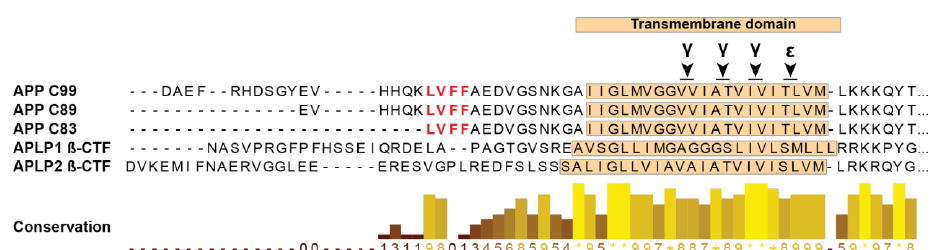
Figure 2. Processing of the APP protein family. ( A ). Illustration of APP processing. The sites of α , β , and β ’ cleavage are shown with amino acids corresponding to cleavage position. Upon cleavage by α - or β -secretase, fragments called s APP α , s APP β and s APP β ’ are released and secreted and C83, C89, or C99 remain embedded in the membrane, respectively. C99 contains the complete A β sequence, while C89 and C83 have truncated (11-X and 17-X, respectively) A β sequences. The A β 17-X is also called the P3 fragment. The first cleavage by γ -secretase occurs at the ε site to release AICD prior to intramembrane proteolytic cleavage of 3 or 4 amino acids to produce amyloid β (A β ) peptides from 36 to 43 amino acids. ( B ). Sequence alignment of APP C99, C89, C83 and APLP1 /2 β -CTF. The alignment illustrates sequence differences between the members of the APP family. The bottom panel highlights amino acids from most conserved (yellow) to less conserved (dark brown). The LVFF motif (red) is present only in APP while the C-terminal fragment is similar between APP and APLP2 . The cleavage sites of γ -secretase are mostly conserved between all members of the APP family. The bottom chart illustrates the conservation of amino acid per position based on their properties with values ranging from 0 (no conservation) to 9 with * representing perfect